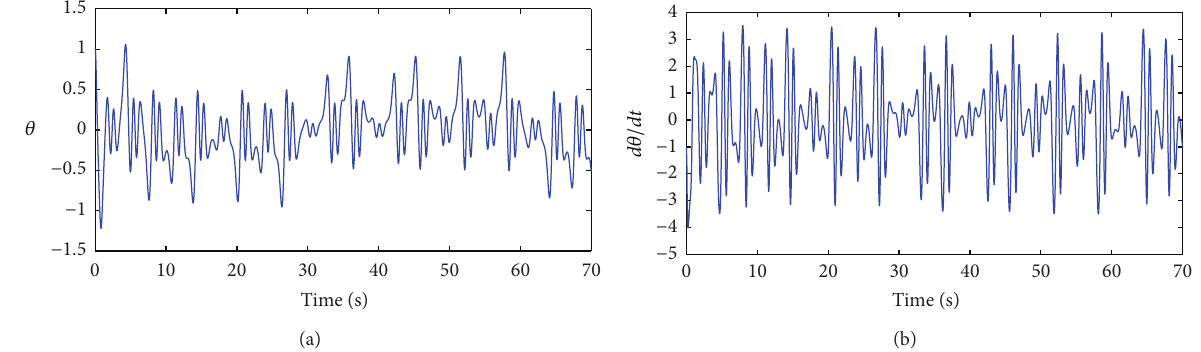
̇𝜃 of the chaotic gyro.